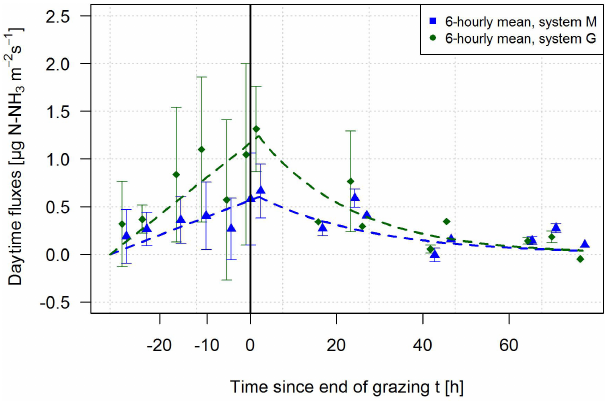
Figure 6. Average temporal pattern of management-related NH 3 emissions for system M (blue) and system G (green) for daytime conditions. Curves with linear increase from the start of grazing un- til 3h after the end of grazing and exponential decrease afterwards were fitted to the 6-hourly averaged values of the measured daytime fluxes. These curves were used as a default emission pattern for flux correction and gap filling (see Sect. 3.2). The vertical bars indicate the standard deviation of averaged half-hourly fluxes. The black ver- tical line indicates the end of grazing. For better readability the data points for the two systems were slightly shifted